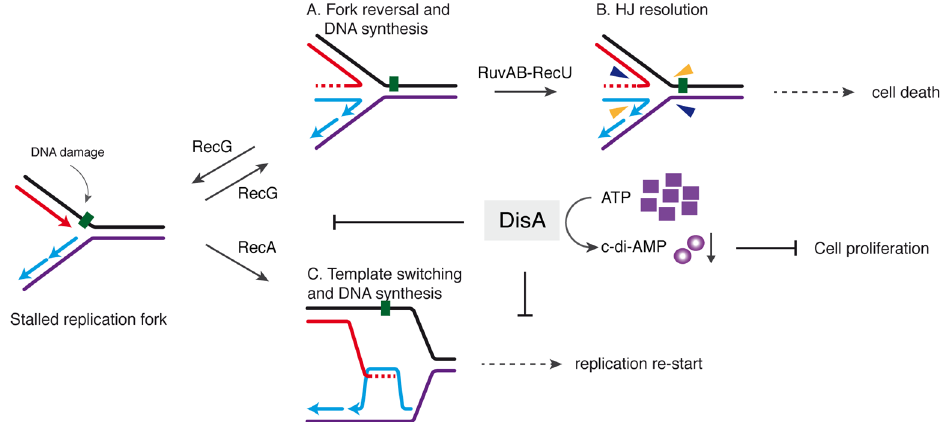
Figure 5. Model for the control of fork remodeling by DisA. DisA moves onto dsDNA synthesizing c-di-AMP until an unrepaired DNA lesion (represented here by the green square on the leading strand template) causes blockage of replication fork movement. The fork remodeler RecG (or RecA) helps DisA to bind the stalled or reversed fork and then DisA-mediated c-di-AMP synthesis is suppressed. Low levels of c-di-AMP indirectly increase in turn (p)ppGpp synthesis which that inhibits DNA replication. In the upper panel, DisA suppresses RecG-mediated fork reversal to avoid fork breakage ( A ). If fork reversal occurs, RecU in concert with RuvAB may catalyze HJ cleavage ( B ), leading to the formation of a one-ended DSB that is lethal during spore revival. In the lower panel, ( C ) RecA-mediated template switching followed by DNA synthesis is also modulated by DisA to allow time for specific enzymes to repair the damage, and then replication